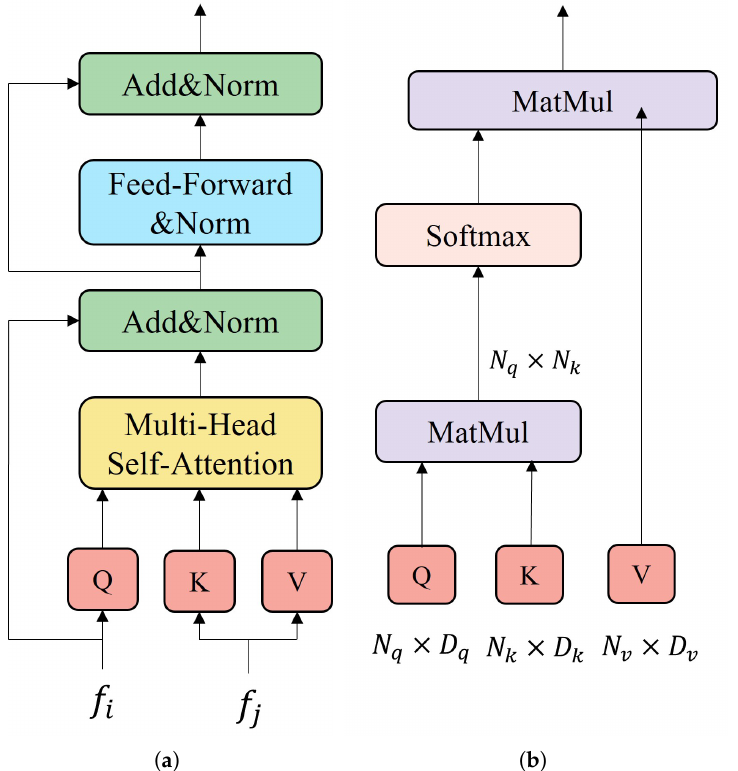
Figure 5. Transformer encoder and dot-product attention layer. The Transformer encoder is made up of L identical layers stacked on top of each other. Each layer has two sub-layers. The first layer is a multi-head self-attention mechanism and the second layer is a simple, fully connected feedforward network. A residual connection is used on both sublayers and followed by layer normalization. The input of the dot-product attention includes the query, key, and value. We compute the dot product of the query with the key and apply a softmax function to get the weights of the value. ( a ) Transformer encoder. ( b ) Dot-product attention